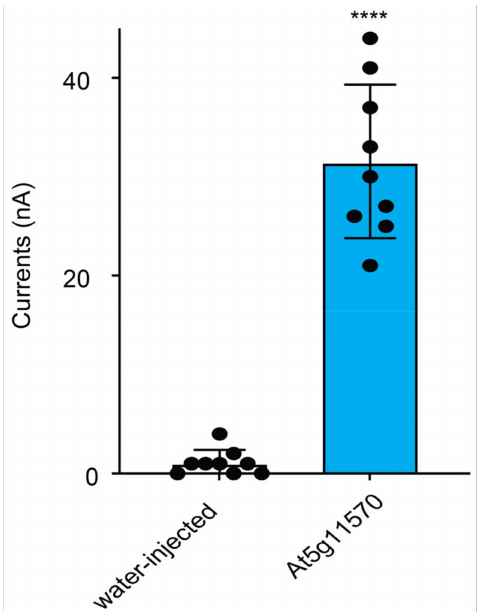
Figure 5. Currents of NPF1.3 using TEVC. Oocytes were injected with water only, cRNAs of NPF1.3, and perfused with CsNO 3 at 5 mM for current recordings. Oocytes were voltage clamped at − 120 mV. The data are the mean ± SE for three experiments. **** indicates the significant difference, p < 0.0001, t -test). Similar results were obtained in at least three independent experiments using different batches of oocytes (one-way ANOVA followed by Tukey’s